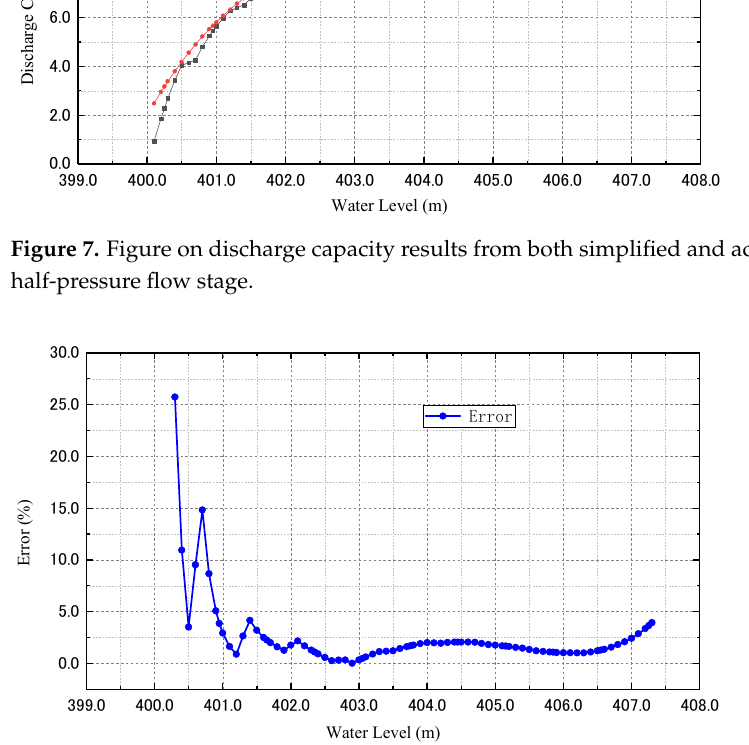
Figure 8. Figure on errors of simplified and accurate algorithms in the half-pressure flow stage.